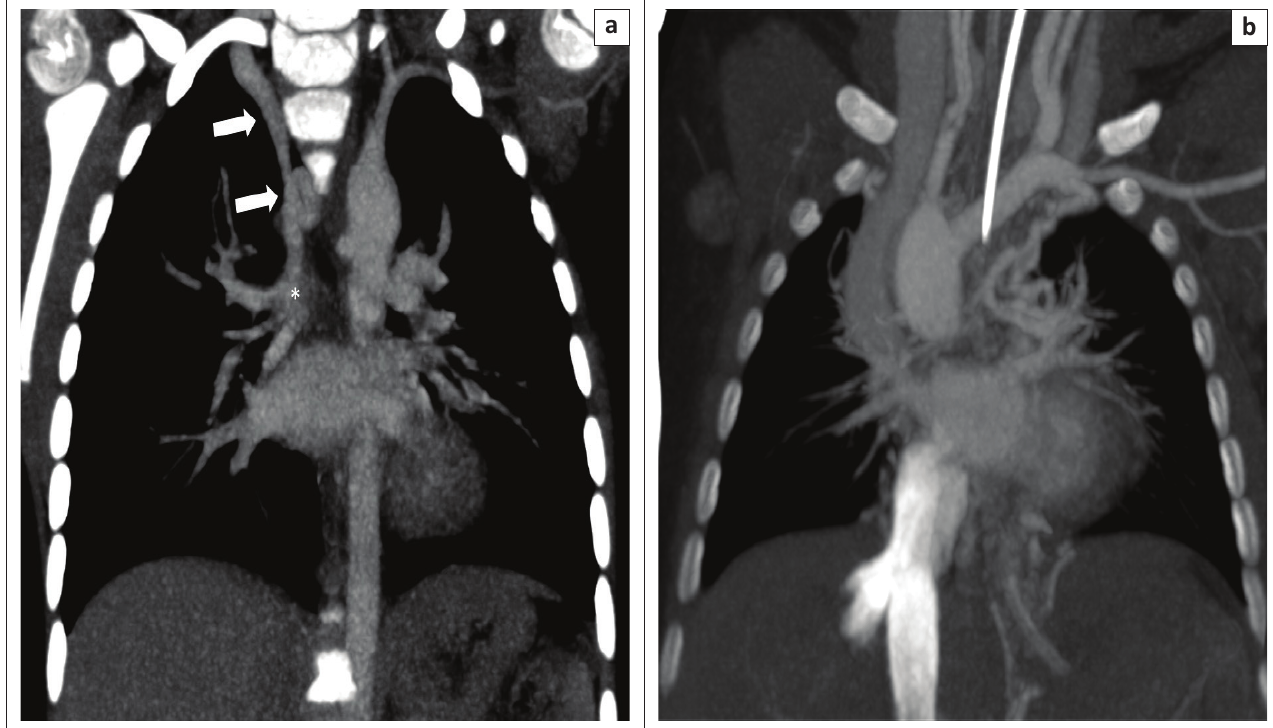
FIGURE 6: Two young TOF patients with large MAPCAs that take origin from the subclavian arteries. Coronal thin-section MPR (a) demonstrating right subclavian artery MAPCA to RPA. Coronal thick-section MIP (b) demonstrating tortuous left subclavian artery MAPCAs to LPA. on the severity of the lesion. The two procedures may occur simultaneously, or VSD closure may only take place post palliation.